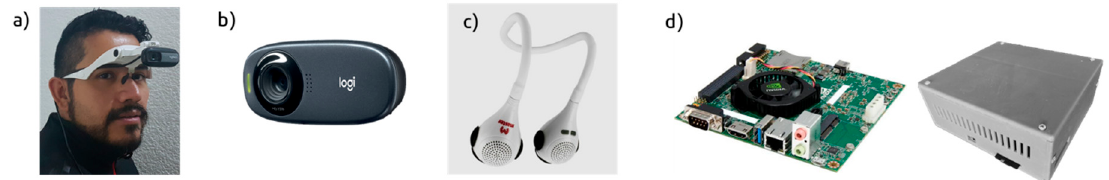
Figure 17. Devices that integrate the face recognition system for people with disabilities. a )